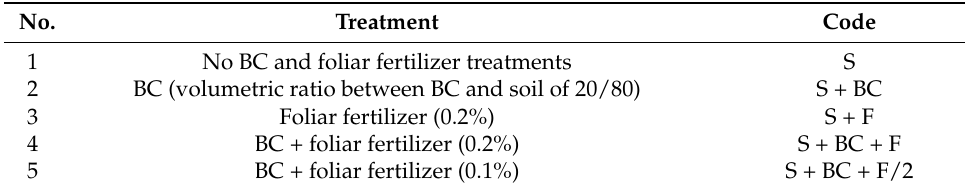
Table 1. Experimental scheme for the greenhouse